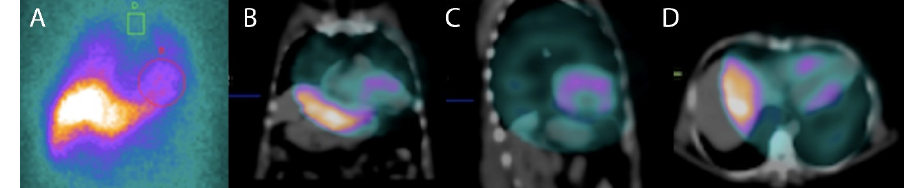
Figure 7. A 123I-MIBG scintigraphy planar scintigraphy in anterior view at 3 h ( A ) to evaluate